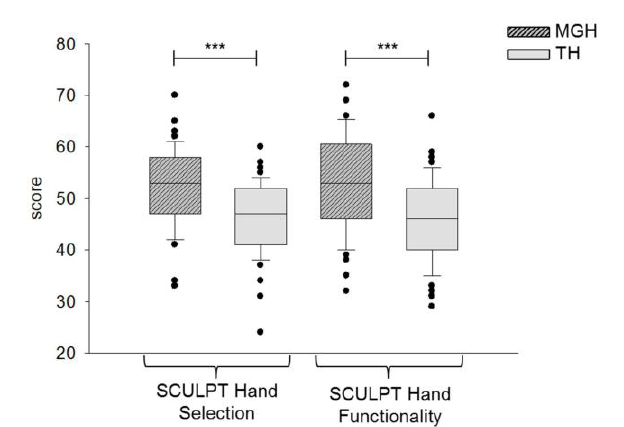
Figure 1. SCULPT hand selection and hand functionality scores for MGH and TH (***